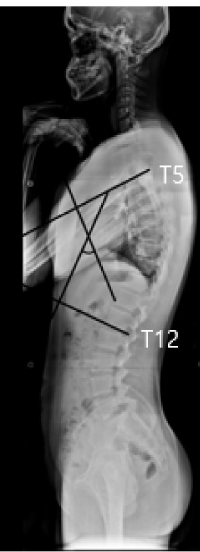
Figure 1. Thoracic kyphosis measured from the upper endplate of the T5 to the lower endplate of the T12 using Cobb’s method.